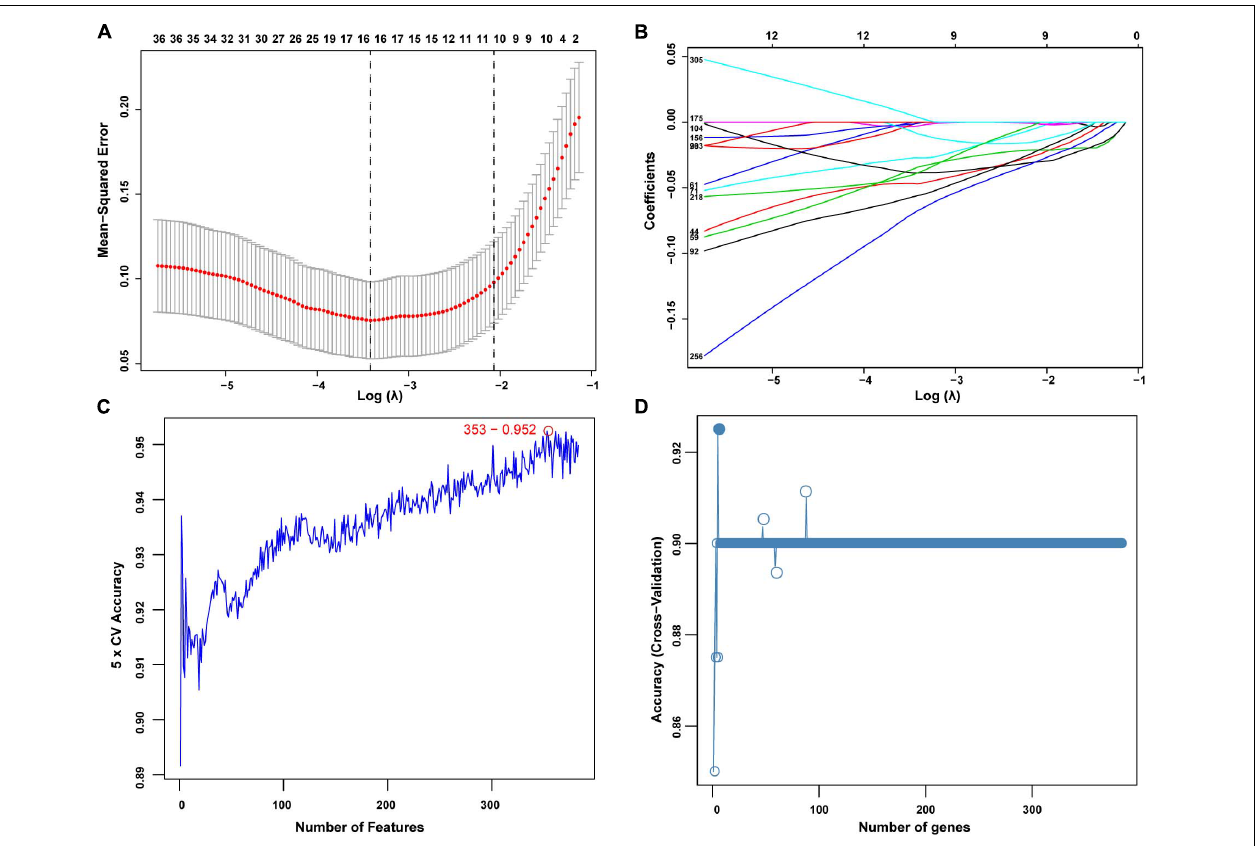
FIGURE 4 | Screening of diagnostic markers via the comprehensive strategy. (A,B) Least absolute shrinkage and selection operator (LASSO) logistic regression algorithm to screen diagnostic markers; Different colors represent different genes; (C,D) based on support vector machine recursive feature elimination (SVM-RFE) and random forest (RF) algorithm to screen